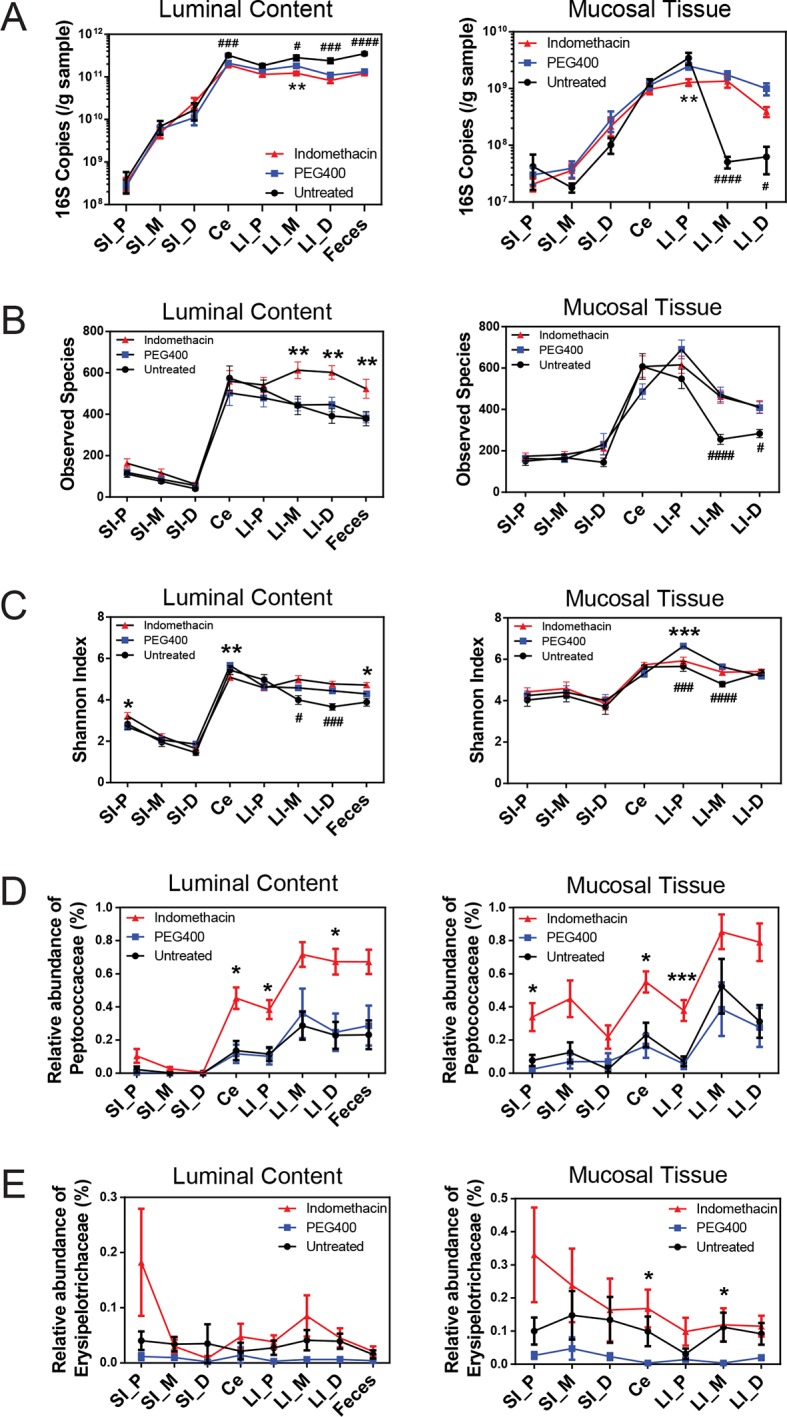
Indomethacin induces changes in microbial composition along the intestine in mice.Bacterial load in samples were inferred from 16S rRNA gene quantitative PCR. Bacterial communities colonized in the mouse intestine were profiled using 16S rRNA gene sequencing and analyzed using QIIME (Caporaso et al., 2010b). (A) 16S rRNA gene copies per gram of luminal contents (left) and mucosal tissues (right) at anatomical sites along the intestine in indomethacin (red), PEG400 (blue), and untreated (black) groups. Microbial loads at anatomical sites along the intestine are barely different between PEG400 and indomethacin groups, although PEG400 causes changes by itself. **p<0.01 by multiple t test comparing PEG400 versus indomethacin groups, FDR corrected. #p<0.05, ###p<0.001, ####p<0.0001 by multiple t test comparing untreated versus PEG400 groups, FDR corrected. N=20/group. Mean ± S.E.M. shown. SI, small intestine; Ce, cecum; LI, large intestine. P, proximal; M, middle; D, distal. Observed Species (B) and Shannon Index (C) are used to estimate richness and diversity of microbial communities in luminal content (left) and mucosal tissue (right) at anatomical sites along the intestine in indomethacin (red), PEG400 (blue), and untreated (black) groups. Indomethacin altered microbial diversity in the distal intestine, although PEG400 also causes changes in the distal intestine by itself. *p<0.05, **p<0.01, ***p<0.001 by multiple t test comparing PEG400 versus indomethacin groups, FDR corrected. #p<0.05, ###p<0.001, ####p<0.0001 by multiple t test comparing untreated versus PEG400 groups, FDR corrected. N=20/group. Relative abundance of Peptococcaceae (D) and Erysipelotrichaceae (E) at anatomical sites along the intestine are significantly elevated in indomethacin (red) group than in PEG400 (blue) and untreated (black) group in both luminal content and mucosal tissues of the distal gut. *p<0.05, ***p<0.001 by QIIME analysis, FDR corrected. Mean ± S.E.M. shown. SI, small intestine; Ce, cecum; LI, large intestine. P, proximal; M, middle; D, distal.